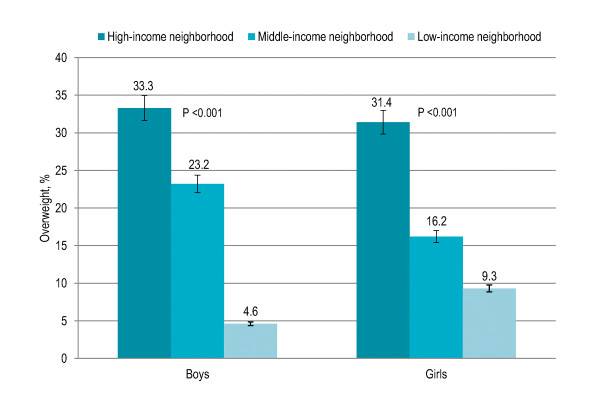
Gender-specific prevalence (with confidence interval bars) of overweight among Pakistani primary school boys (n = 977) and girls (n = 883) by neighborhood income level.